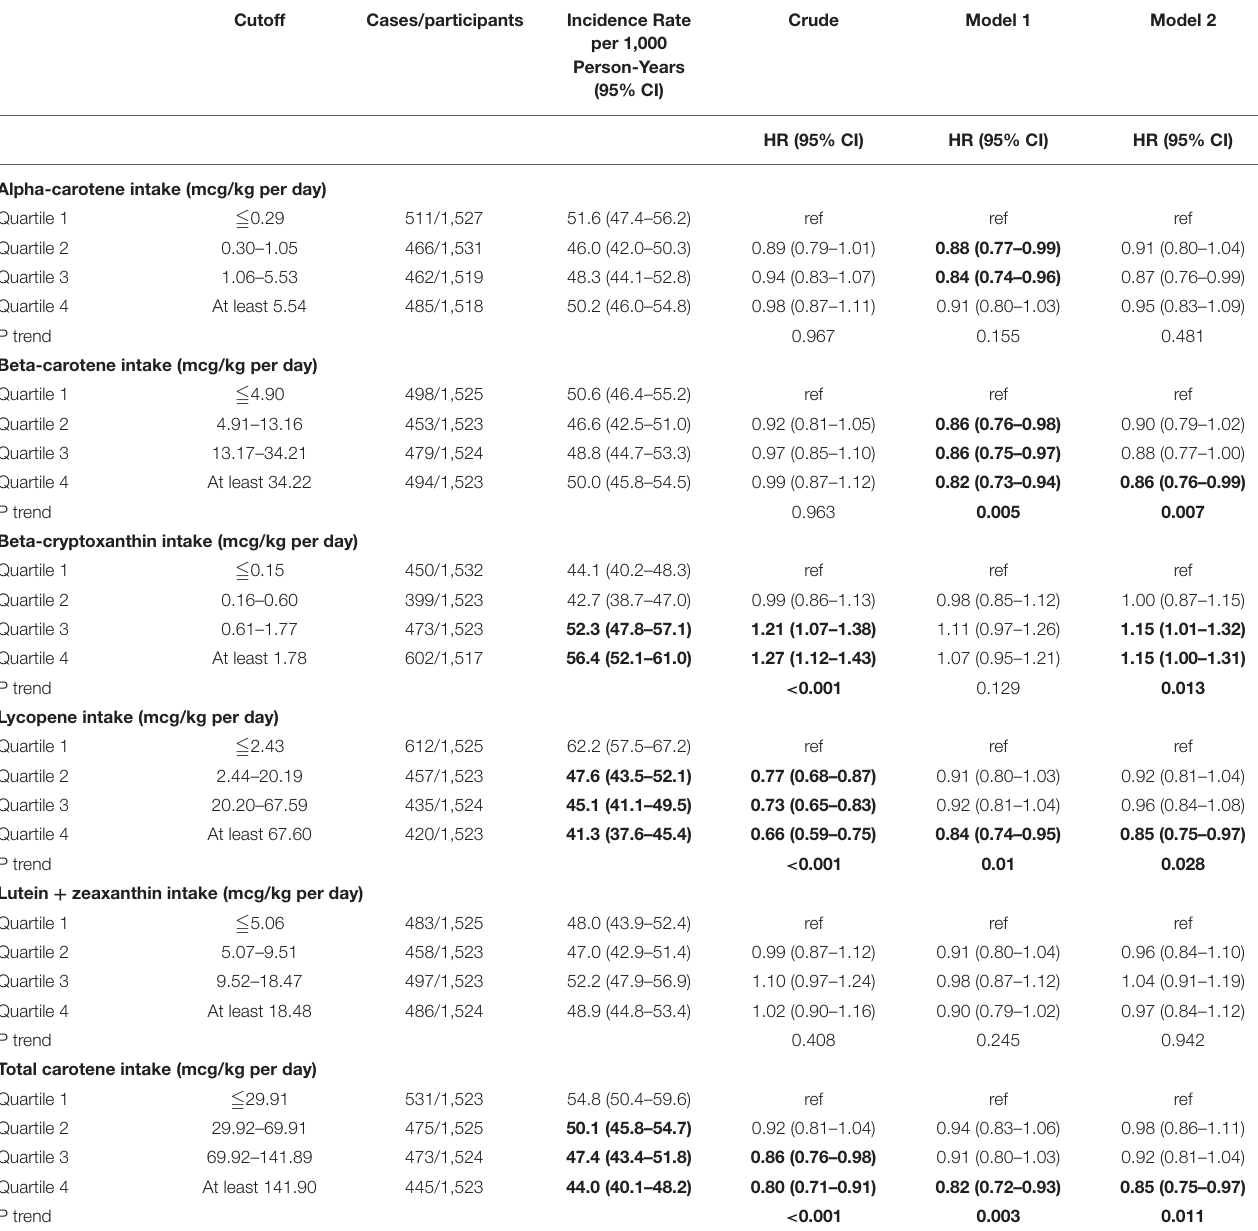
TABLE 2 | The associations of daily intakes of carotene with mortality. Cutoff